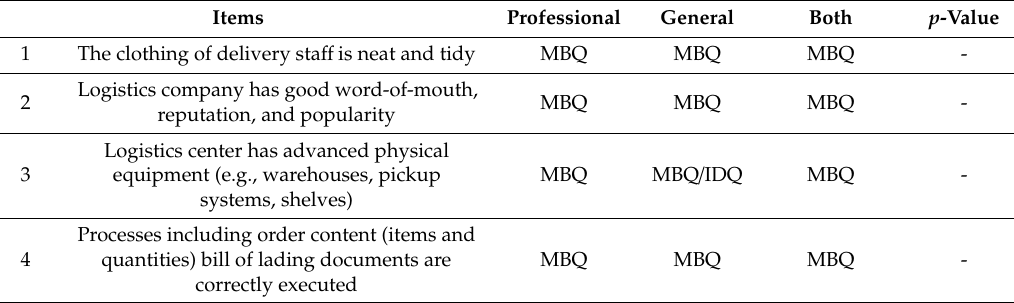
Table 5. Categorization of quality elements by logistics service